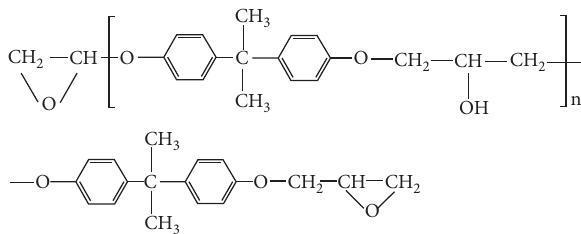
Figure 1: Molecular structure formula of bisphenol A epoxy resin, where “ n ” is the average degree of polymerization, the number of repeating structural units in the molecule.